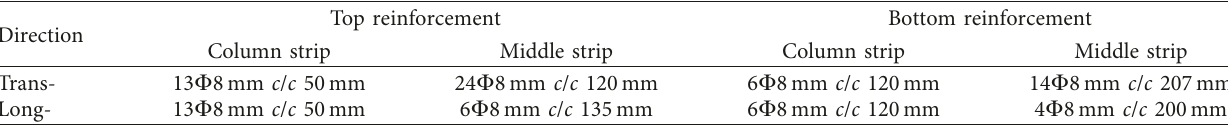
Table 5: Detail reinforcement of flat